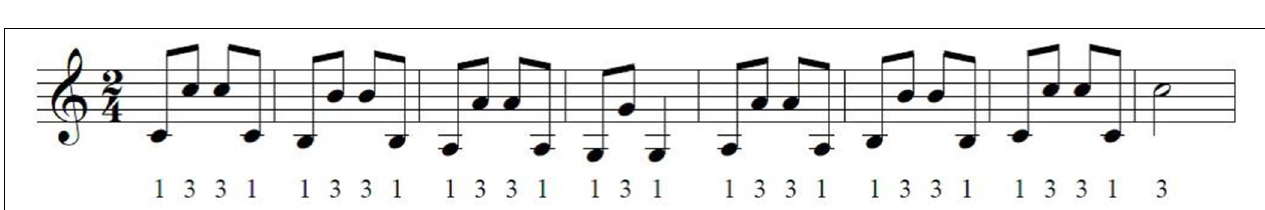
FIGURE 4 | The large-strong condition (LS): large hand span (i.e., fingers stretching across an octave) with only strong fingers, i.e., the thumb (1) and middle (3) fingers involved.